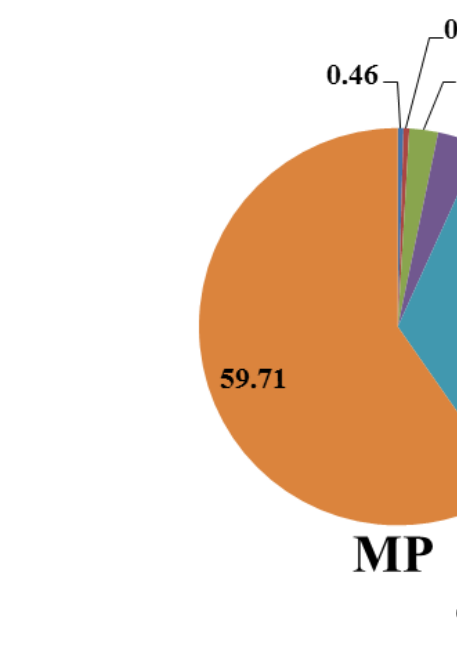
Figure 4. Fertilizer N distribution in plants (%). ( a ) Fertilizer N distribution in plants under NT. ( b ) Fertilizer N distribution in plants under MP.